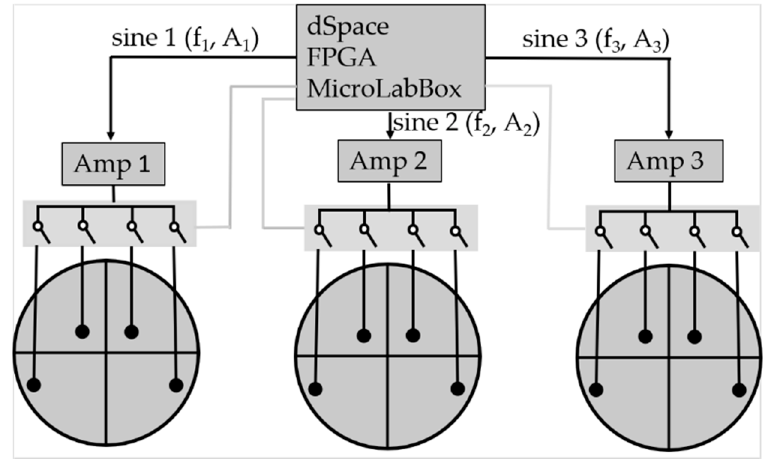
Figure 5. Signal generation and distribution to the electrodes to control the platform.